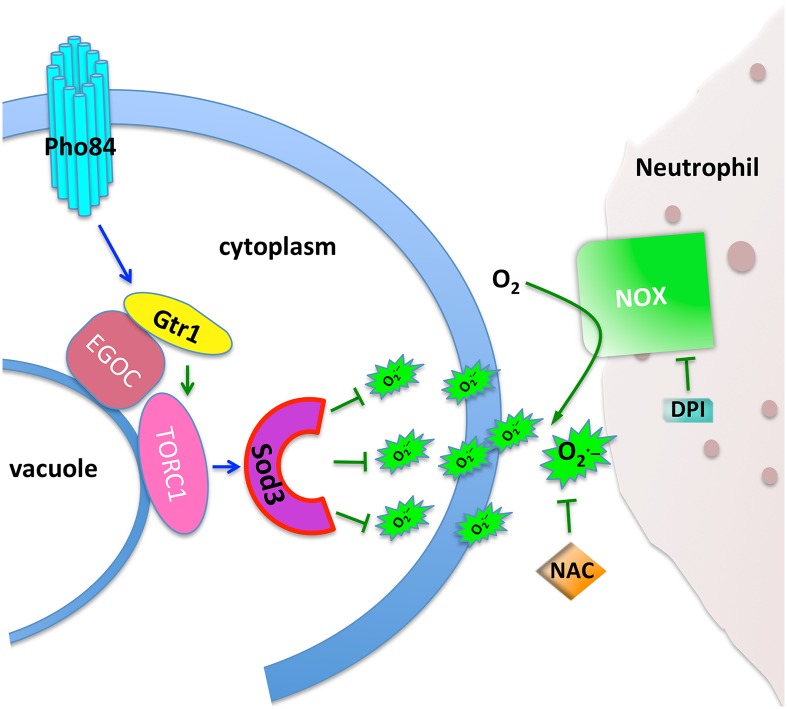
Pho84 activates TORC1 via Gtr1 to modulate Sod3 expression in combating neutrophil derived ROS.Signalling events with known molecular mechanisms in C. albicans are shown as green lines. Blue lines represent predicted activities based on our findings.